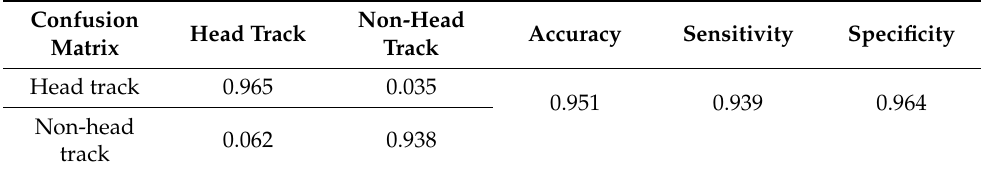
Table 5. Tracking Accuracy achieved over the GOTPD dataset.